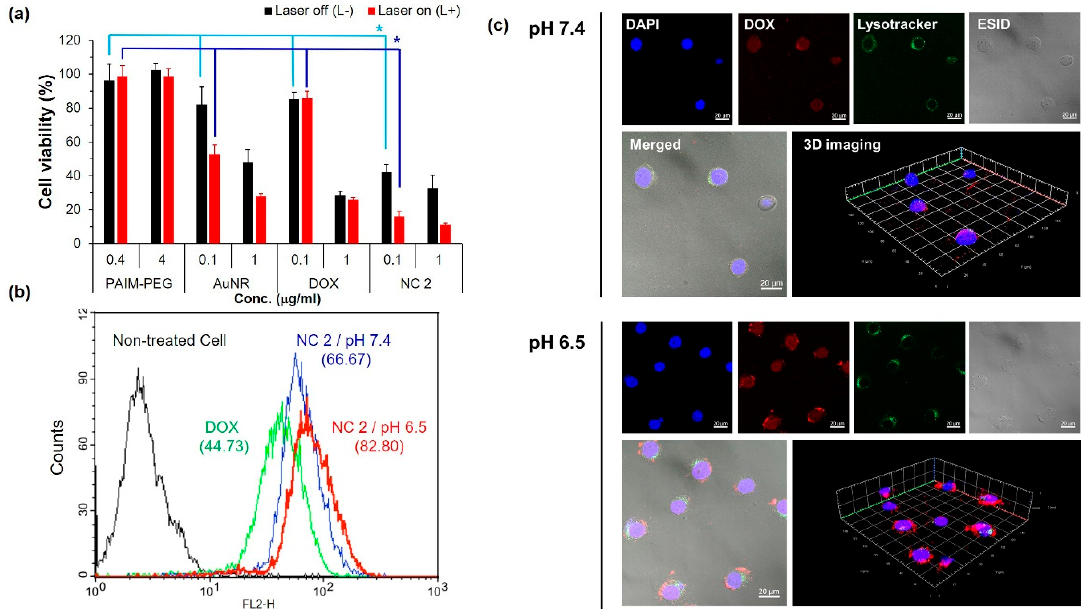
Figure 3. In vitro study of NC: ( a ) Cell viability of KB cells treated with poly(aspartic acid-graft- imidazole)-PEG (PAIM-PEG), AuNR, DOX, and NC 2 with or without an NIR laser (808 nm, 2 W/cm 2 , 2 min); * indicates a combination index (C.I.) < 1.0. Nanocluster effect on cellular uptake